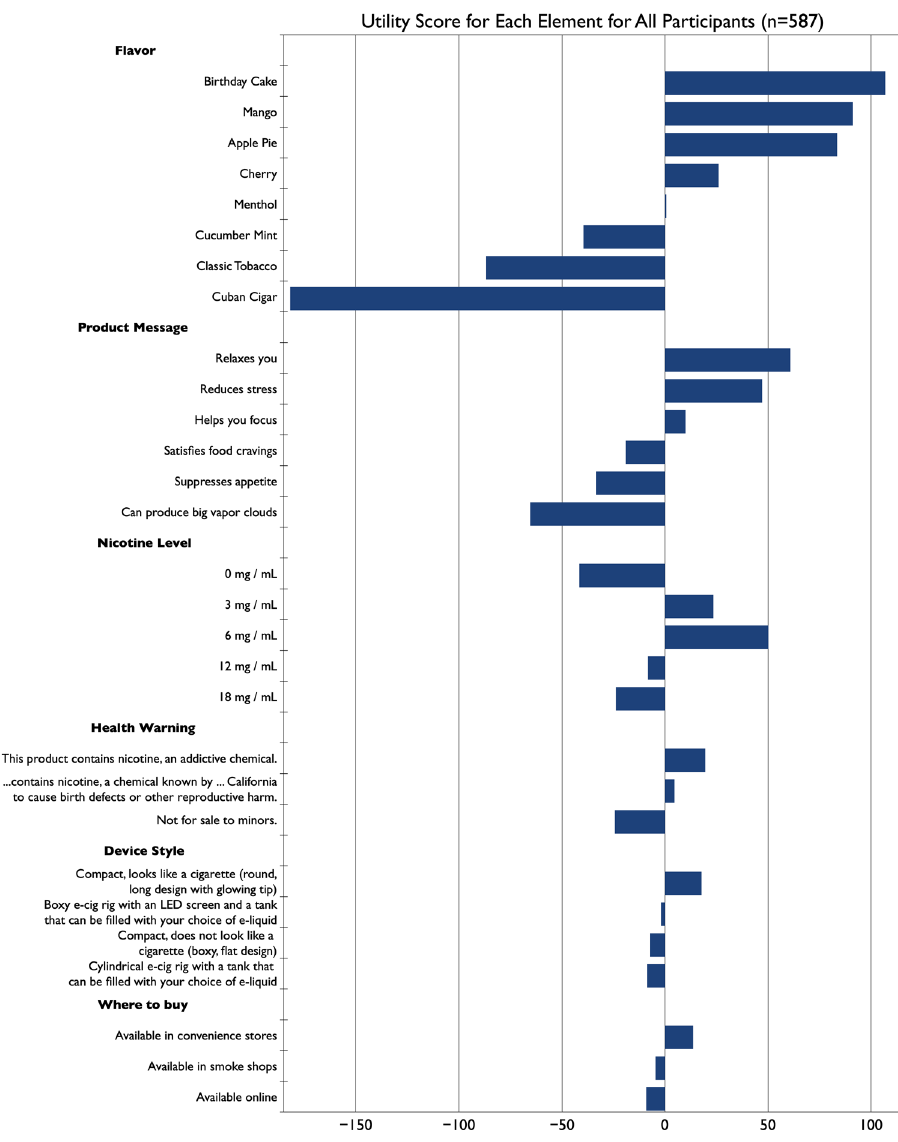
Figure 2. Utility scores of individual elements across all participants, ordered vertically by importance of each category. Elements with positive scores are to the right, and negative scores are to the